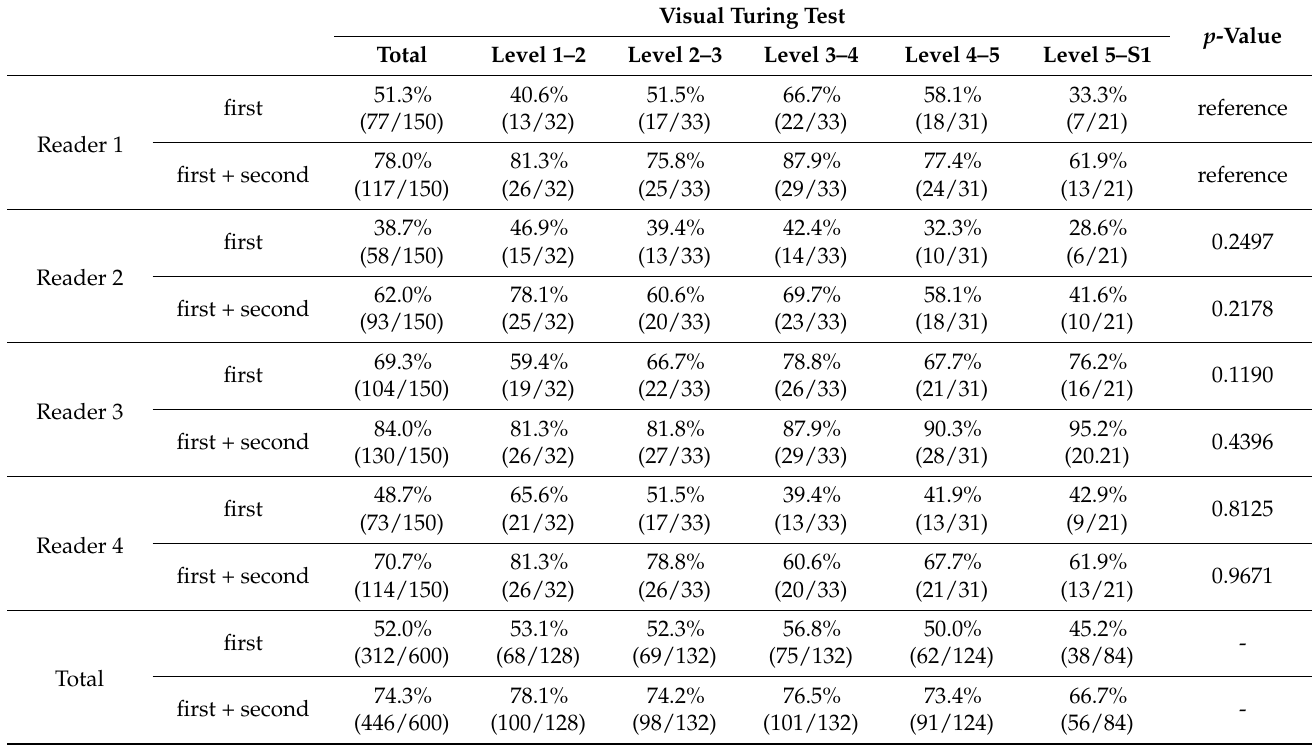
Table 2. Assessment of the choice of true lumbar MR images through the VTT by the four